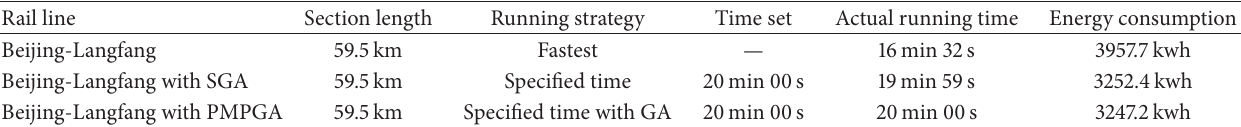
Table 4: Comparison of running